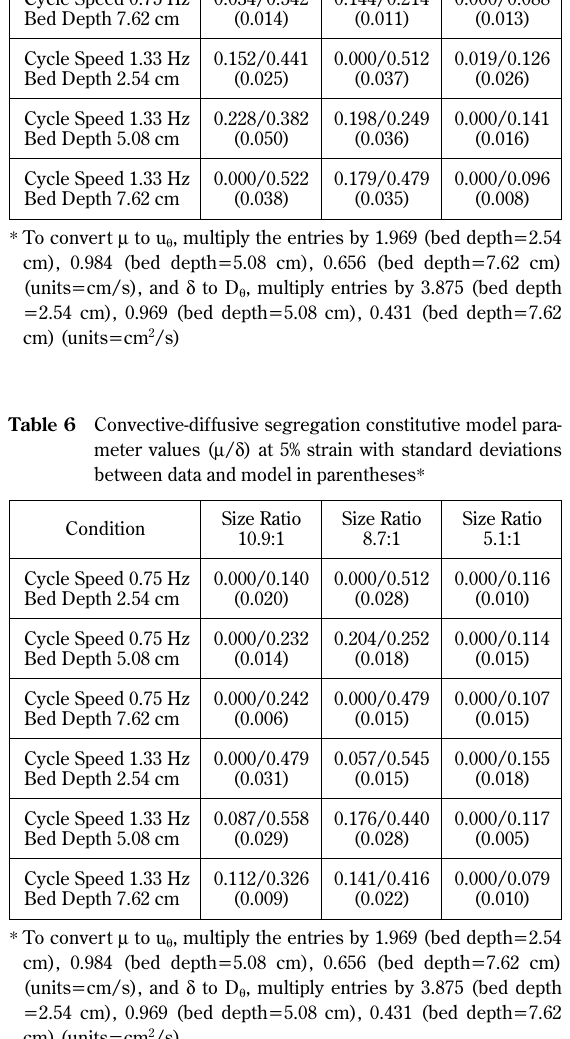
Measured Data (cid:1) – Strain (cid:5) 15% (cid:1) – Strain (cid:5)